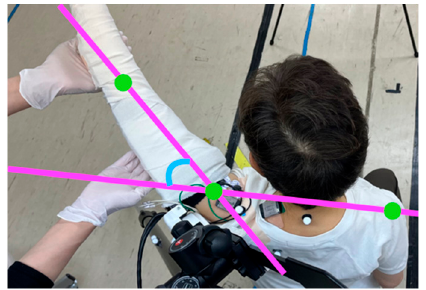
Figure 2. Images showing scapular elevation.